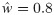
Connectivity properties of the SOM-VIP motif support the amplification in the interneuron network.(A) Network of inhibitory PV, SOM and VIP neurons with short-term facilitation (STF) of SOM→VIP and VIP→SOM connections (left). STF increases the amplification index. Smaller mutual inhibition strengths are sufficient to achieve an amplification index above the amplification threshold A = 0 (right). Inset: The dynamics of the mutual inhibition strength (’weight’) after a step increase of the presynaptic firing rate from 0/s to 5/s for three different values of the initial release probabilities. STF parameters are equal for SOM and VIP neurons: Us = 0.1 (strong STF), Us = 0.5 (weak STF), Us = 1 (no STF) and τf = 100 ms. (B) Network of inhibitory PV, SOM and VIP neurons with artificially introduced recurrent connections among both SOM and VIP neurons (left). Recurrence leads to a decrease of the amplification index (right). Recurrence strengths are equal for SOM and VIP neurons. Mutual inhibition strength w^=0.8.